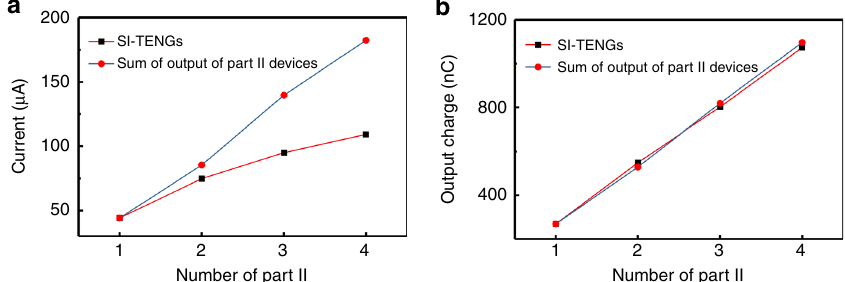
Fig. 5 Output current and charge of multilayer self-improving triboelectric nanogenerators. Output current ( a ) and charge ( b ) of the multilayer self- improving triboelectric nanogenerators (SI-TENGs) with different numbers of part II devices and the sum of the output of corresponding part II devices working independently